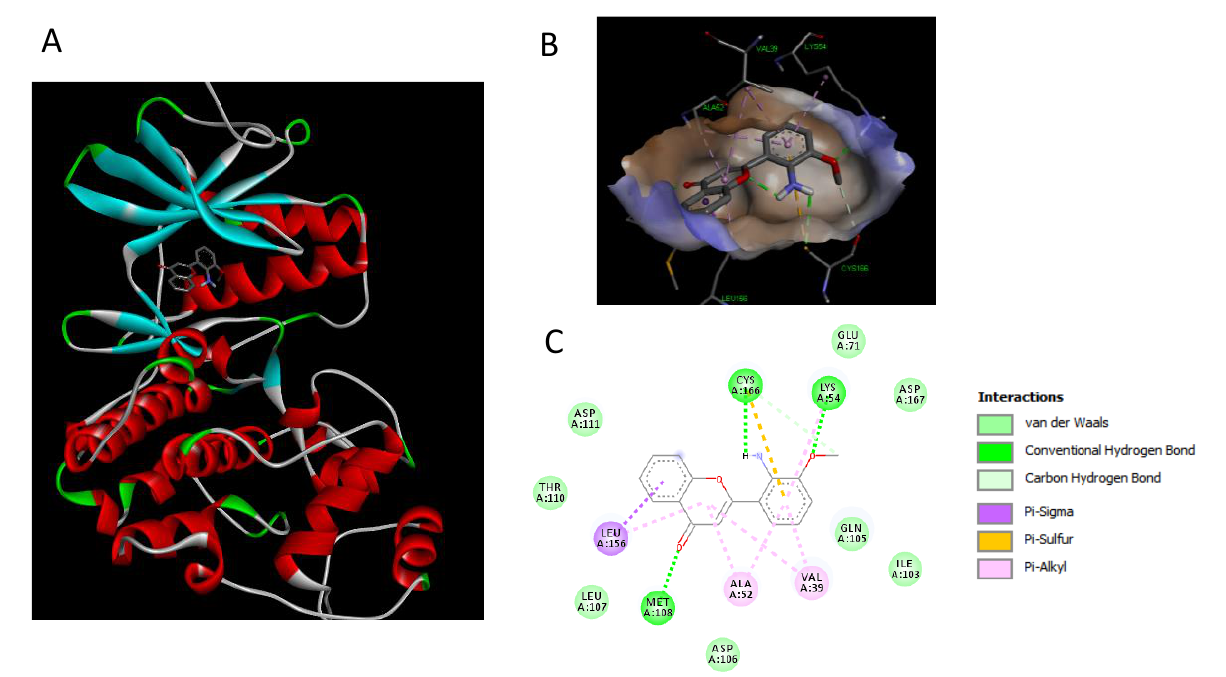
Figure 12. Binding modes and binding-interaction diagrams of Erk inhibitor PD98059, PD bound to Erk. ( A ): PD bound at the ATP-binding site of Erk; ( B ): binding interaction between PD and Erk; ( C ): binding-interaction diagrams of PD and Erk.